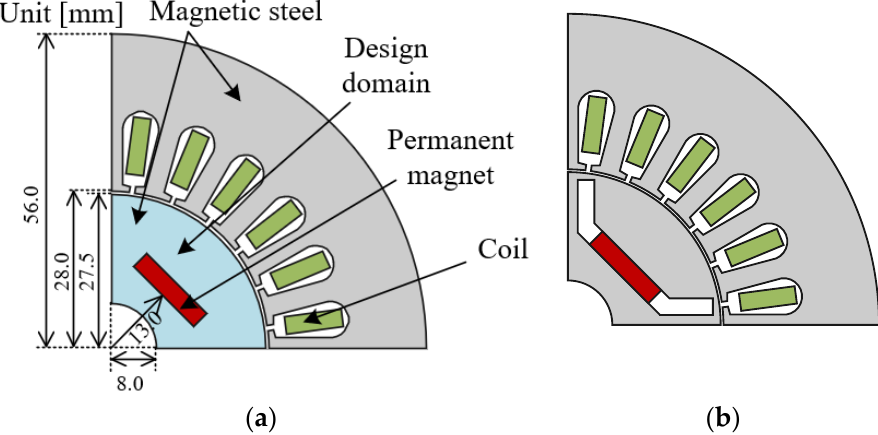
Figure 10. ( a ) is the configuration of the 24-slot 4-pole IPMSM, and ( b ) is the reference model.